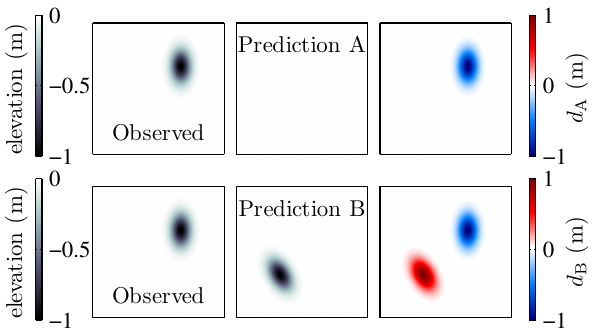
Fig. 1. The “double penalty effect”. Top panels: the featureless pre- diction A has a non-zero difference d A between predicted and ob- served depth values at the location of the observed feature only. Lower panels: prediction B, which reproduces the feature at the wrong location, is penalized twice ( d B is non-zero both where the predicted feature is and where it should be) and is thus diagnosed with a twice as large (R)MSE as prediction